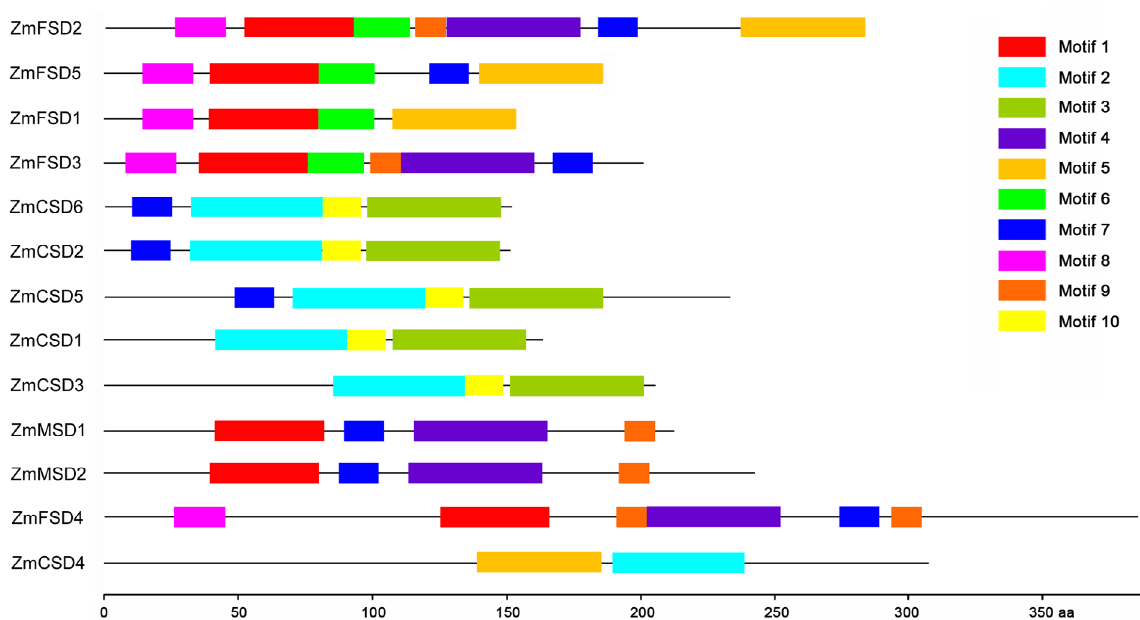
Figure 3 ‒ Conserved motif analysis of ZmSOD